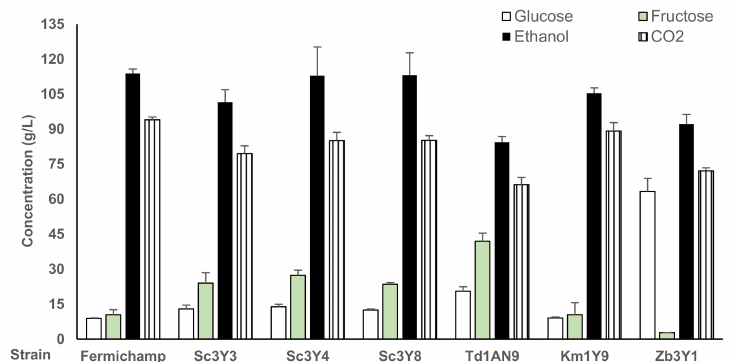
Figure 1. Hexose consumption and primary metabolite production for the selected Saccharomyces and non- Saccharomyces yeasts fermenting individually in grape juice medium at a sugar concentration of 137 g / L initial glucose and 119 g / L initial fructose at 144 h. Values are the average of six measurements, and standard deviations are presented as error bars. Table 4. Biomass, acetic acid, and glycerol productions and productivity parameters for the